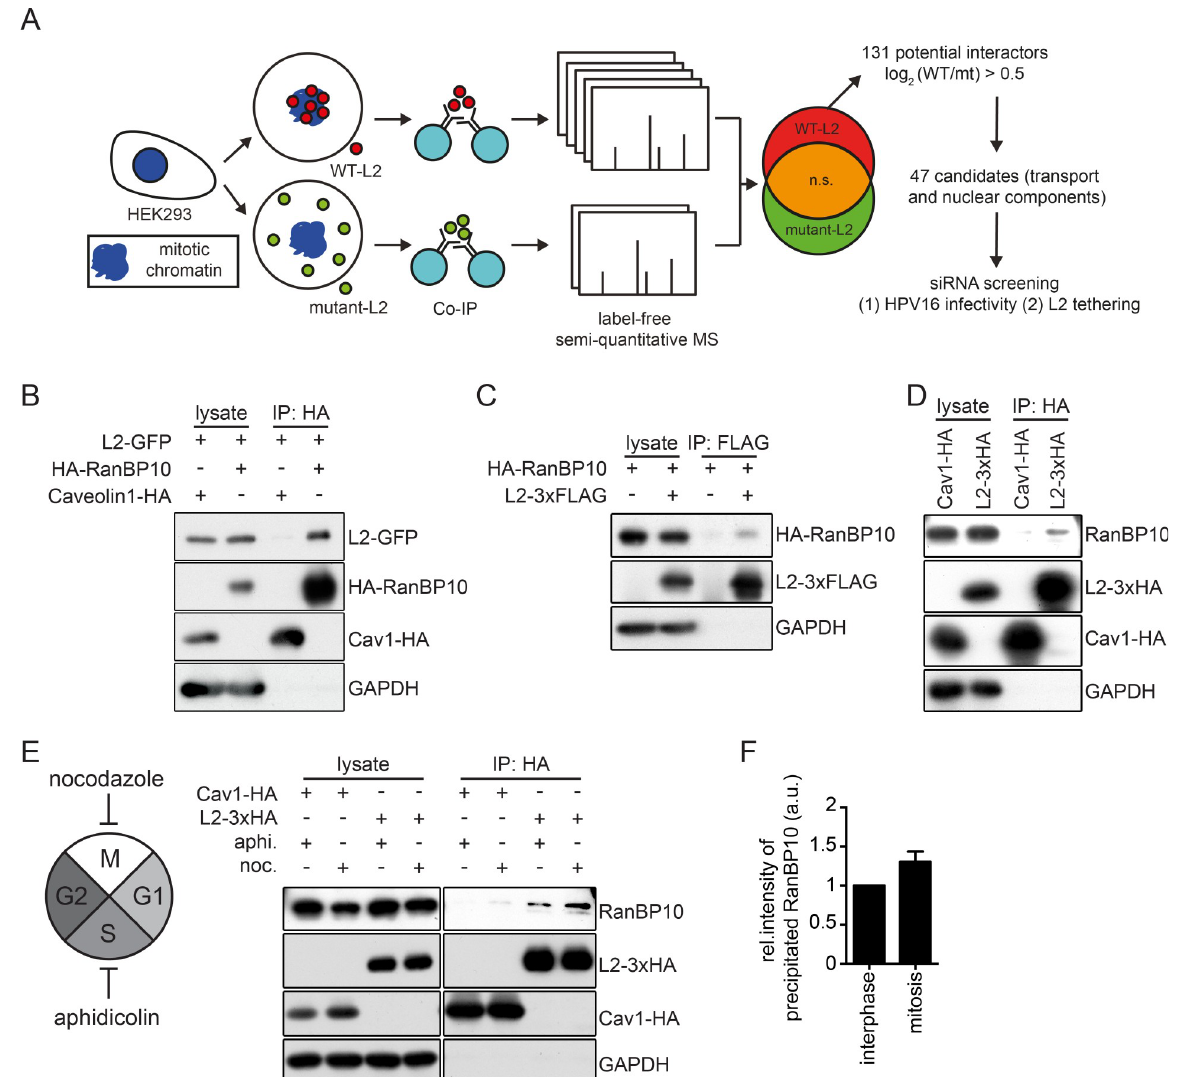
Fig 1. Identification of a novel L2 interaction partner during mitosis. (A) Overview of the experimental strategy to identify mitotic L2 interactors using label-free semi-quantitative mass spectrometry. HEK293 cell lysates expressing wild-type L2-3xHA or RTR313EEE-mutant L2- 3xHA were subjected to immunoprecipitation with an HA antibody. Cellular proteins co-precipitating with L2 were identified by label-free semi- quantitative mass spectrometry and analyzed with MaxQuant v1.5.3.12. 47 candidates were selected and preliminarily tested on their functional roles in HPV16 infectivity and L2 chromatin association. (B) Immunoprecipitation of HEK293 cell lysates co-expressing L2-GFP and HA-RanBP10. Caveolin 1-HA (Cav1-HA) was used as a negative control for the HA-tag pull-down. (C) Reverse pull-down for (B). Immunoprecipitation of HEK293 cell lysates co-expressing RanBP10 and L2-3xFLAG with a FLAG-tag antibody. (D)(E) Immunoprecipitation against HA in (D) unsynchronized or (E) synchronized HEK293 cells expressing L2-3xHA, followed by detection of endogenous RanBP10. Cells were synchronized for 16 hours with either aphidicolin (3 μ M) to result in interphase-arrested cells or nocodazole (330 nM) to result in prometaphase-arrested cells. Caveolin 1-HA (Cav1-HA) was used as a negative control. (F) Quantification of RanBP10 immunoprecipitates from (E) of three independent experiments. Given are values relative to interphase levels ±